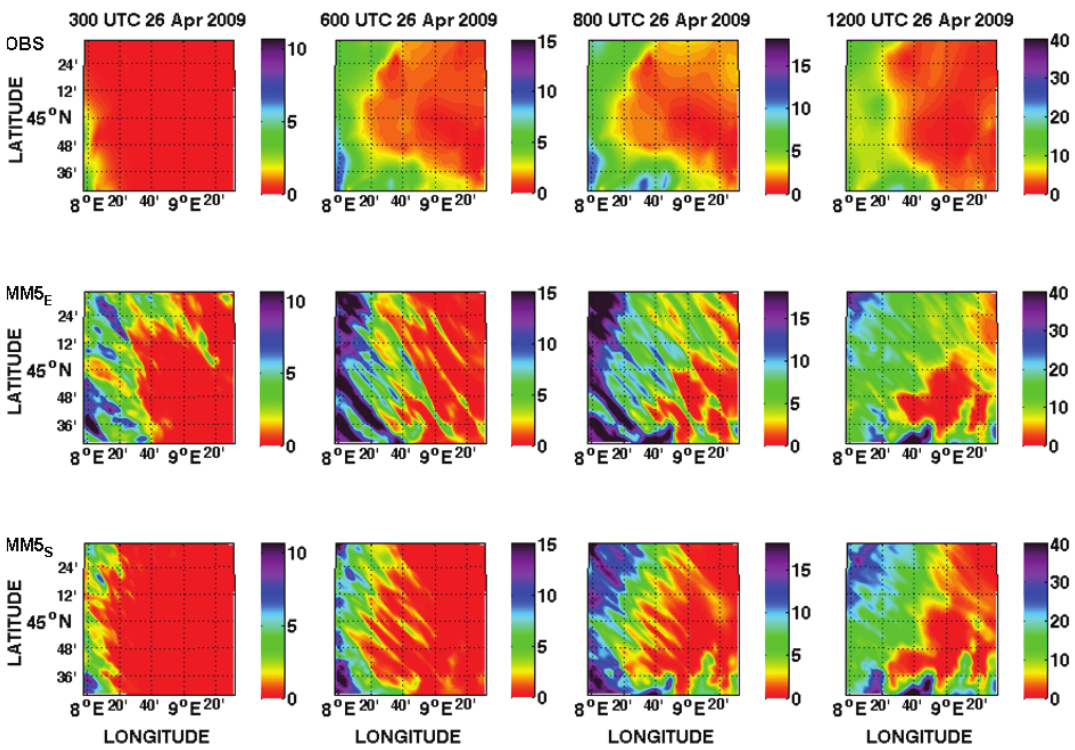
Fig. 7. 6h accumulated precipitation (mm) on 26 April in domain 4 from rain gauges (top panels), MM5 E run (middle panels), and MM5 S run (bottom panels). First column: 03:00UTC; second column: 06:00UTC; third column: 08:00UTC; fourth column: